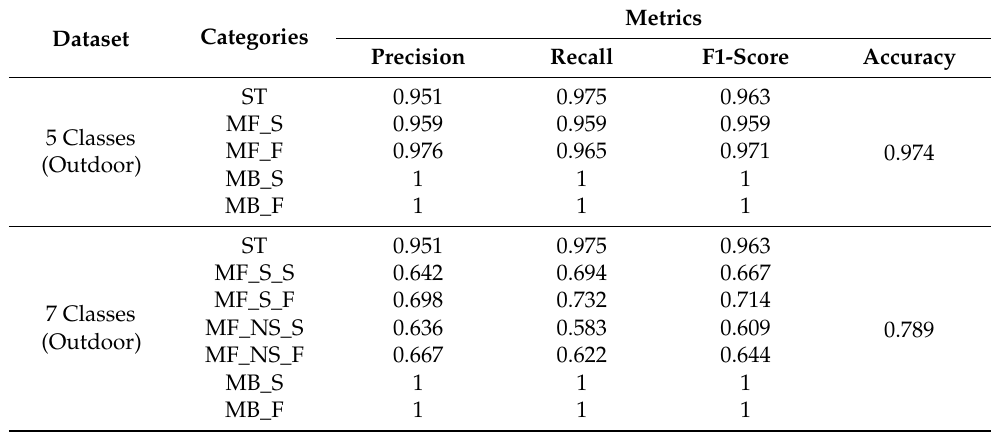
Table 5. Performance of the Proposed Model in the Outdoor